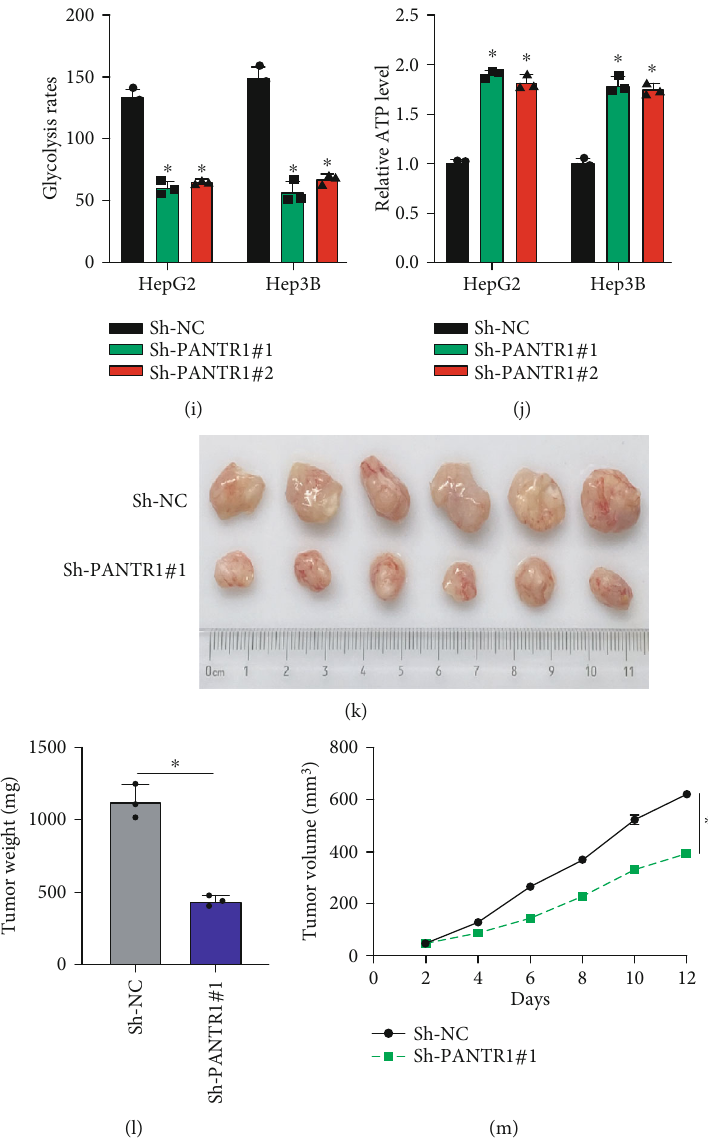
Figure 2: Downregulation of PANTR1 inhibits cell functions in vitro and in vivo . (a) The transfection e ffi ciencies of Sh-NC, Sh-PANTR1#1, and Sh-PANTR1#2 in HepG2 and Hep3B cells were detected by qRT-PCR. (b, c) The proliferation ability of HepG2 and Hep3b cells pretransfected with Sh-NC, Sh-PANTR1#1, and Sh-PANTR1#2 was assessed by CCK-8 assay. (d, e) The apoptosis rate of HepG2 and Hep3b cells pretransfected with Sh-NC, Sh-PANTR1#1, and Sh-PANTR1#2 was measured by fl ow cytometer assay. (f, g) HepG2 and Hep3b cells pretransfected with Sh-NC, Sh-PANTR1#1, and Sh-PANTR1#2 were subjected to Transwell migration assay for migration level detection. Comparative statistics are shown. Scale bars: 20 μ m. (h – j) The Warburg e ff ect phenomenon-related lactate production (h), glycolysis rates (i), and ATP levels (j) were detected as indicated. Data are shown as the mean ± standard deviation . All assays were repeated in triplicate. NOD/SCID mice (6 weeks old) were subcutaneously inoculated with HepG2 cells ( 1 × 10 6 per tumor) pretransfected with Sh-NC or Sh-PANTR1#1. (k) Representative image of inoculated tumors. (l) Tumor end weights were recorded and analyzed. Comparative statistics are shown. (m) Tumor volumes on days 2, 4, 6, 8, 10, and 12 were recorded. Data are shown as the mean ± standard deviation ( n = 3 ). ∗ P < 0 : 05 and ∗∗ P < 0 : 01